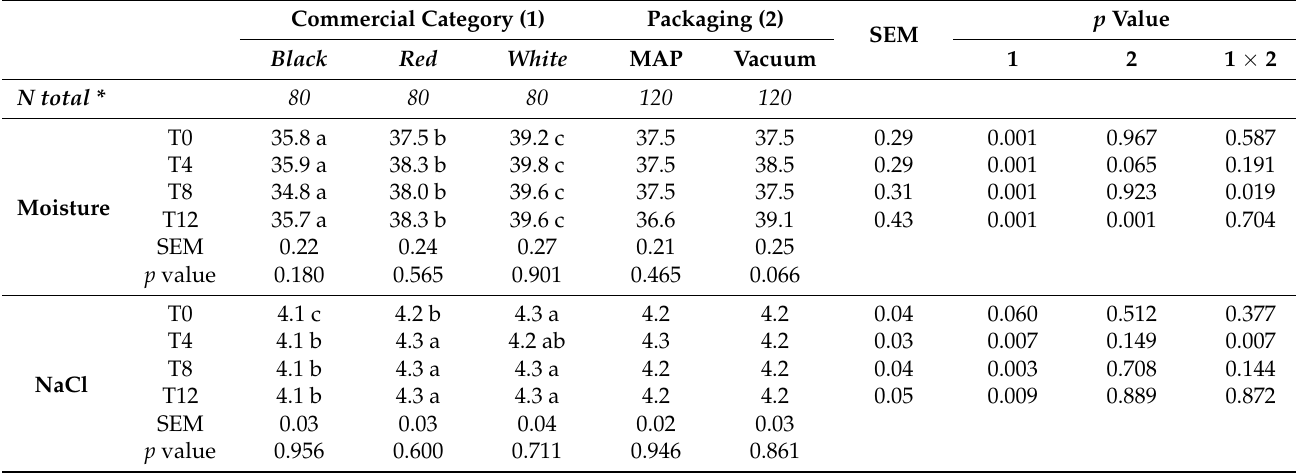
SEM, standard error of mean; Values with the same letters (a–c) indicate homogeneous subsets according to p ≤ 0.05, p ≤ 0.01, p ≤ 0.001. a–c: Different letters in the same row indicate significant differences in the commercial category for p = 0.05 according to Tukey’s HSD test. Black (100% Iberian pigs finished in Montanera); Red (50% Iberian × Duroc pigs finished in Montanera); White (50% Iberian × Duroc pigs reared in a semi-intensive system with commercially feeding). Modified atmosphere packaging (MAP) (70% N 2 :30% CO 2 ). Vacuum packaging. T0, initial; T4, 4 months of storage; T8, 8 months of storage; T12, 12 months of storage. * N total, number of determinations performed for each commercial category and for each type of packaging.